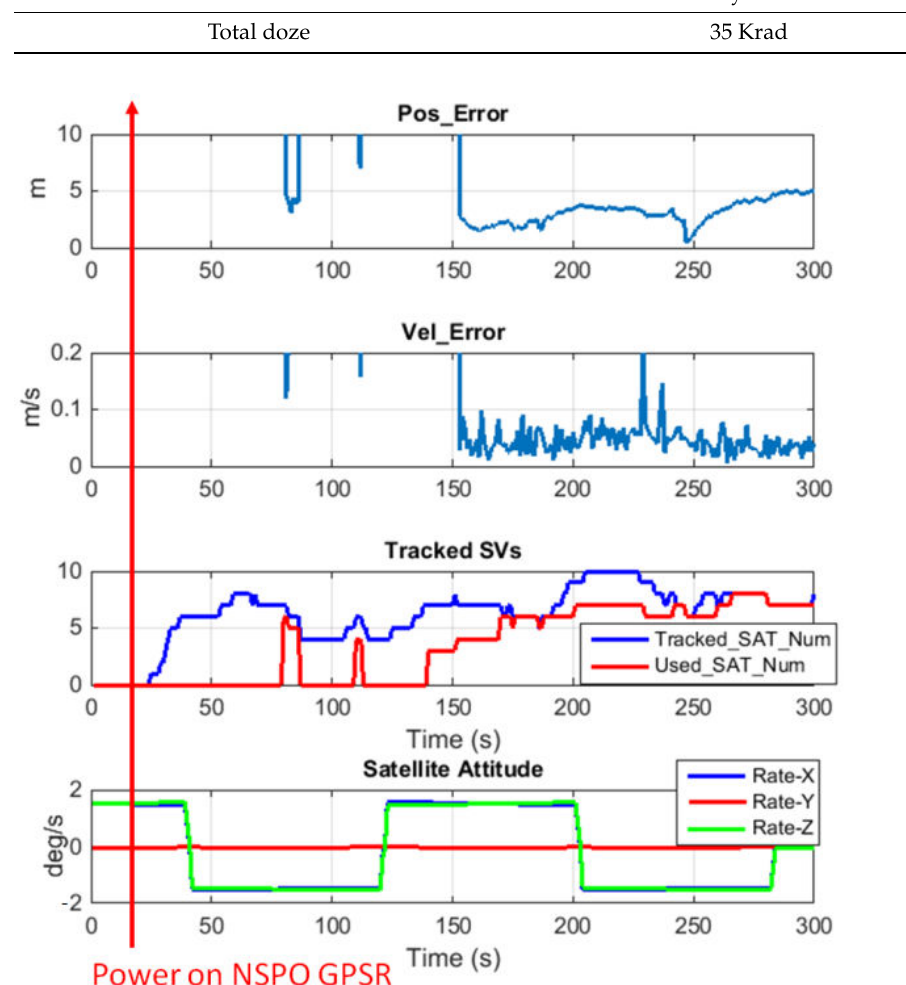
Figure 7. The tracking stability of the NSPO